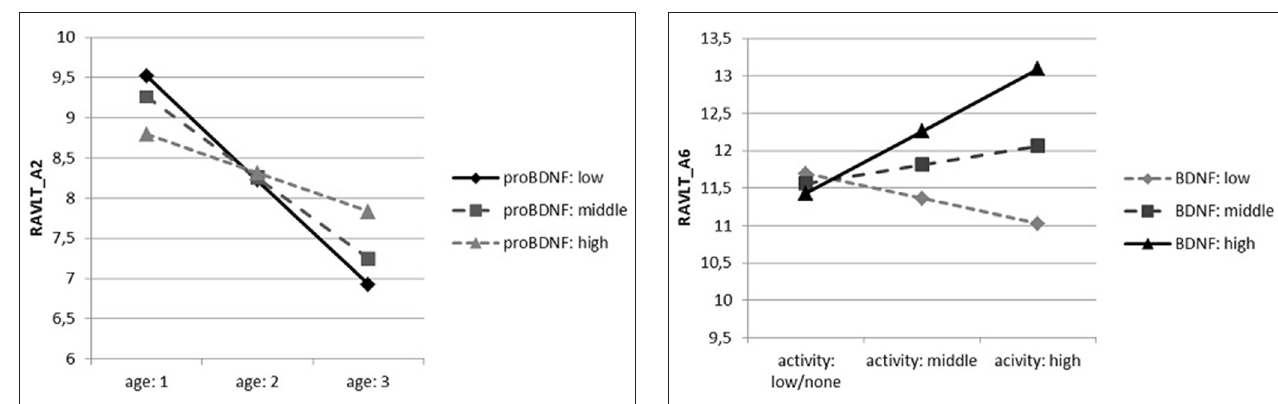
FIGURE 3 | The dependence of the results of RAVLT_A6 on the physical activity (number of days in a month in which physical activity is performed), moderated by proBDNF